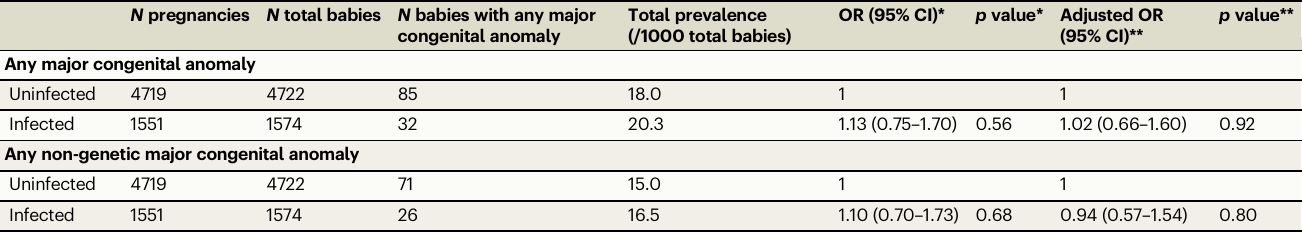
Table 6 | Odds ratios for the association between SARS-CoV-2 infection and major congenital anomalies among babies reaching at least 12 weeks gestation, calculated using conditional logistic regression models N pregnancies N total babies N babies with any major Total prevalence congenital anomaly (/1000 total